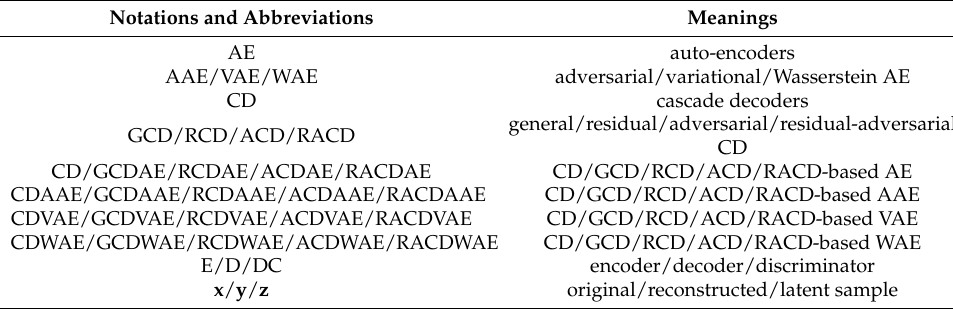
Table 2. Mathematical notations and abbreviations.